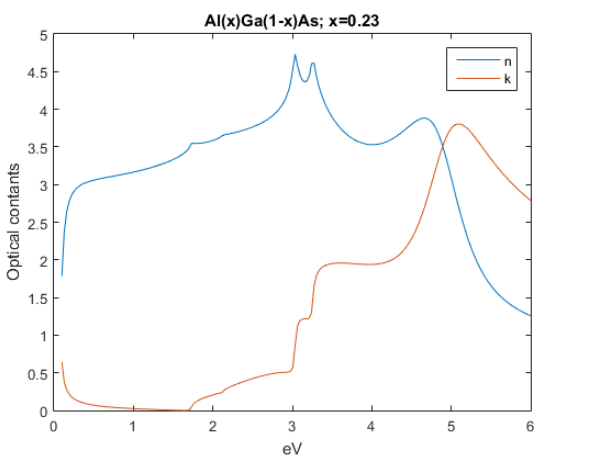
Figure 4. Real and imaginary optical constants of Al 0.23 Ga 0.77 As .